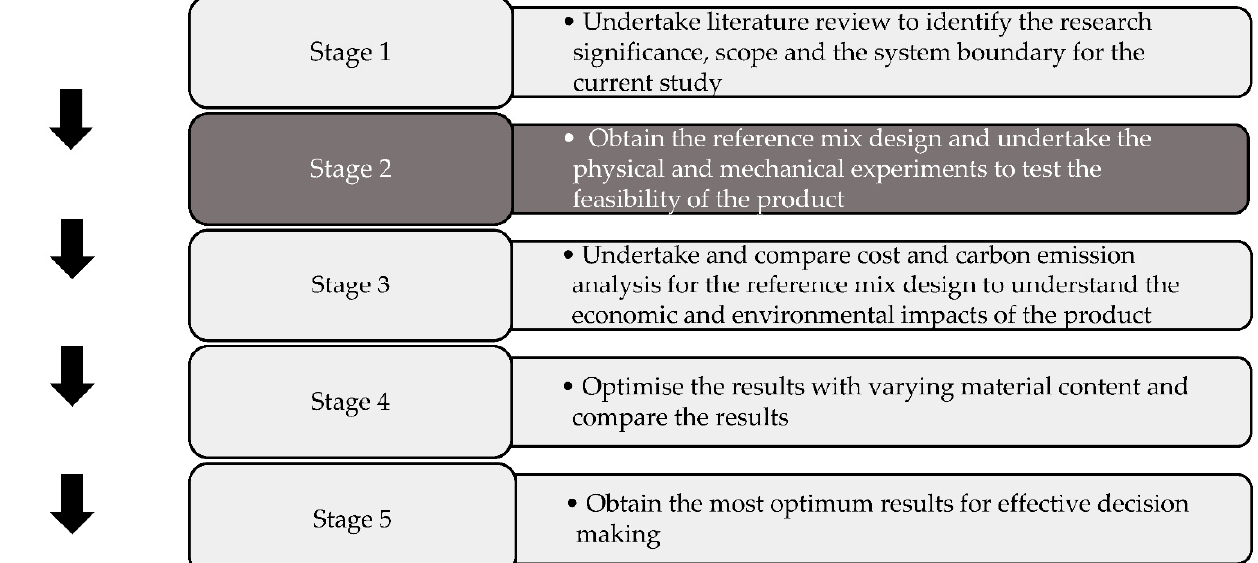
Figure 1. Research methodology for the current study .